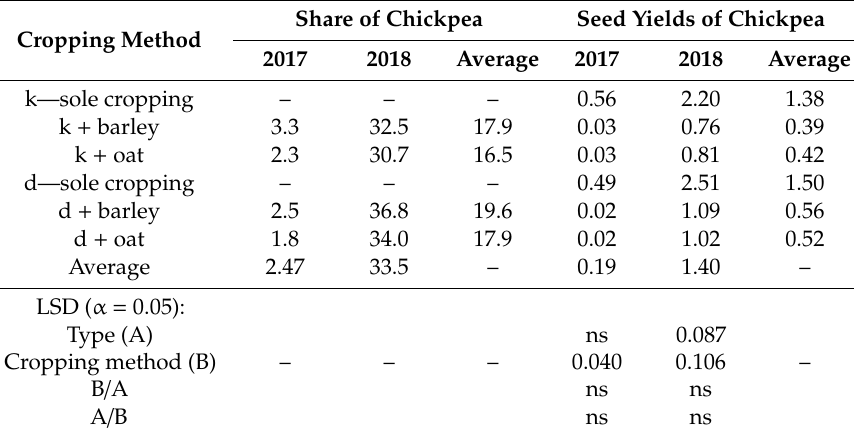
Table 2. Share of chickpeas (%) and seed yields (t · ha − 1 ) depending on cropping method and type (k—kabuli; d—desi; ns—not significant at Tukey’s test P ≤